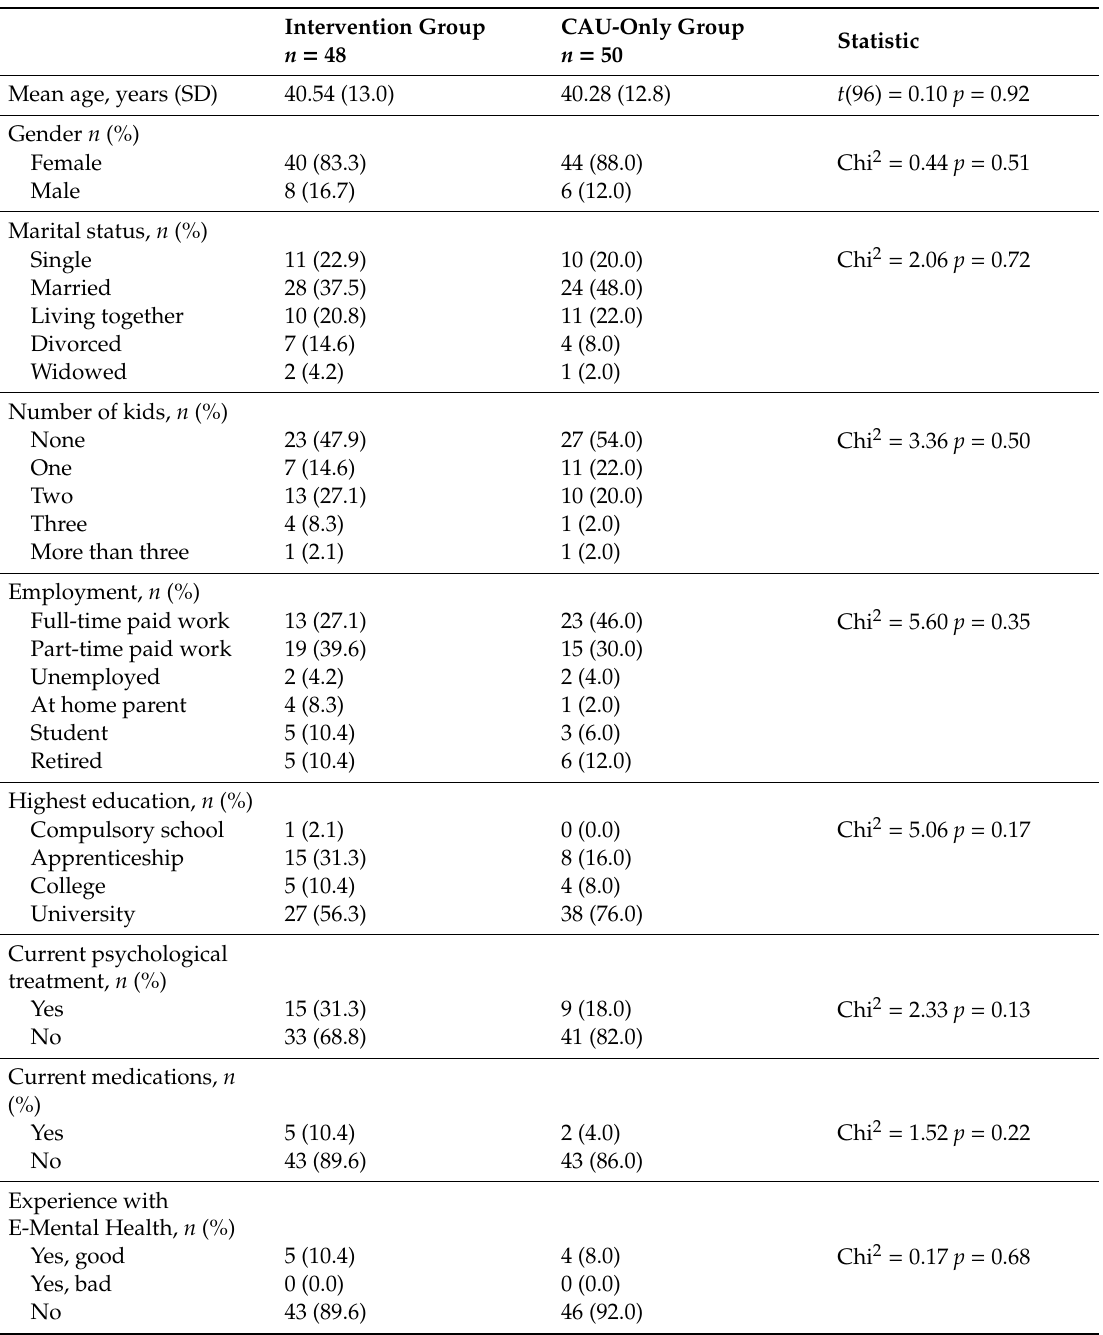
Table 2. Pre-Treatment